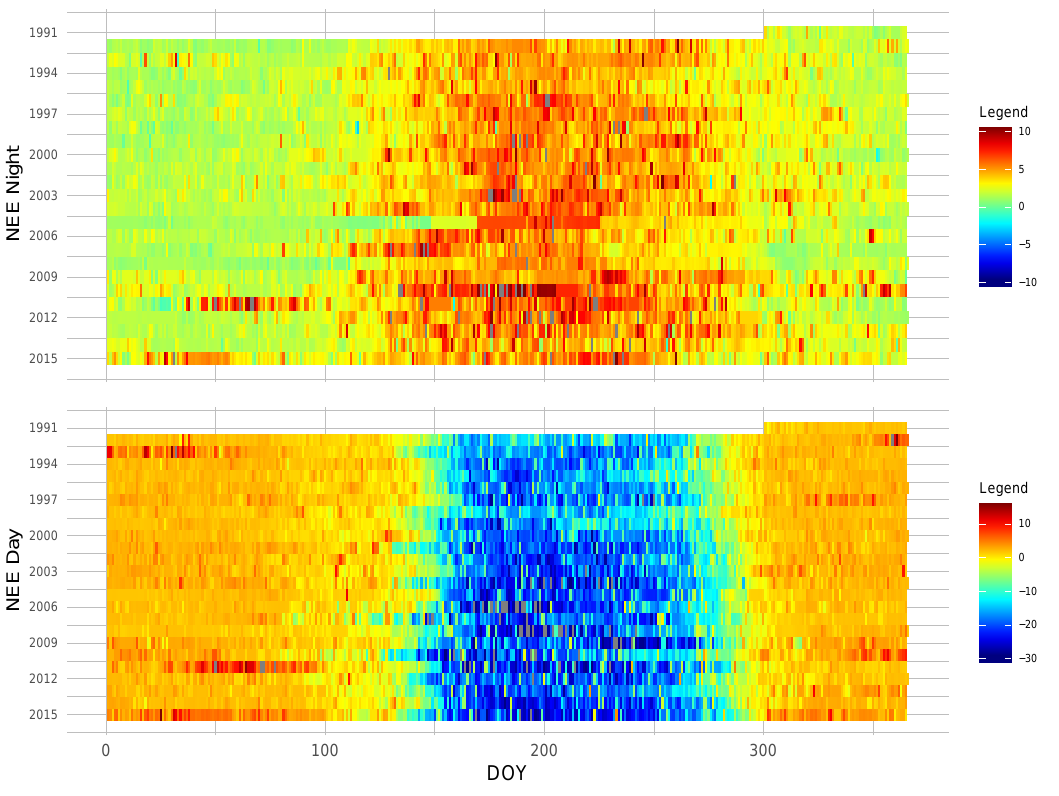
Figure A2. HF-EMS tower daily diurnal